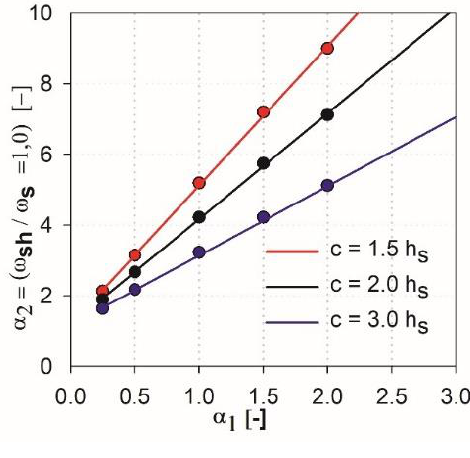
Figure 11. Summary of the analysis results—EC2.